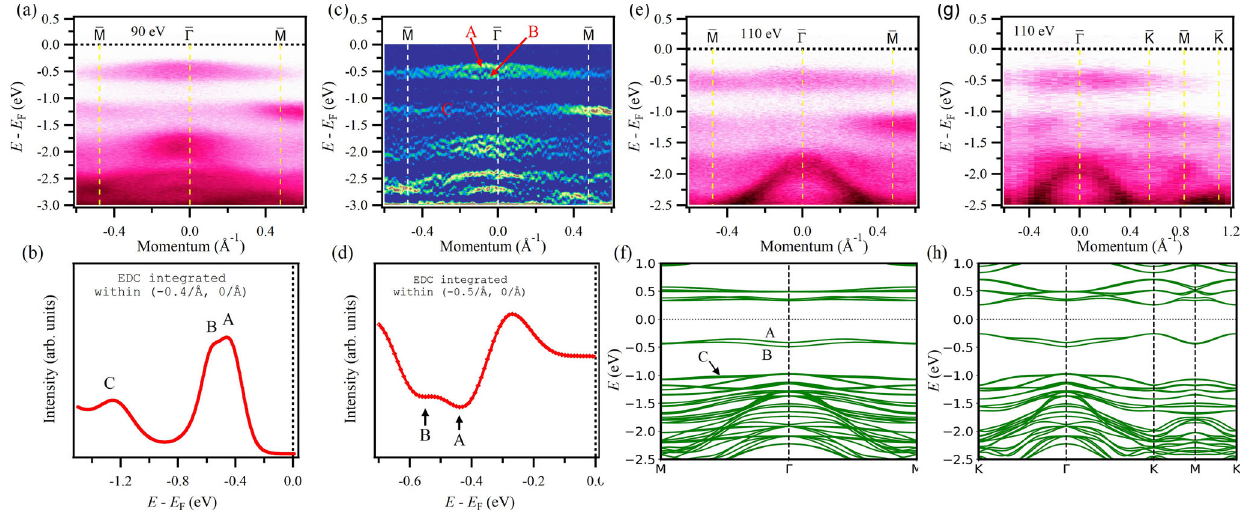
Fig. 3 Observation of fl at and weakly dispersing bands. a , b ARPES measured band dispersions along M (cid:1) Γ (cid:1) M measured using photon energy of 90 eV and Integrated EDC (Voigt fi t, also see Supplementary Note 6 and Supplementary Fig. 9) within a momentum window of ( − 0.4/ Å – 0/ Å ) in ( a ). c , d Second derivative plot of dispersion map in a and respective EDC curve taken within momentum window of ( − 0.5/ Å – 0/ Å ), respectively. e Experimental band dispersion along M (cid:1) Γ (cid:1) M direction. f Calculated bands along M − Γ − M. g Experimental band dispersion along the Γ (cid:1) K (cid:1) M (cid:1) K direction. h Calculated bands along Γ − K − M − K. ARPES data were collected at the ALS beamline 4.0.3 at a temperature of 260